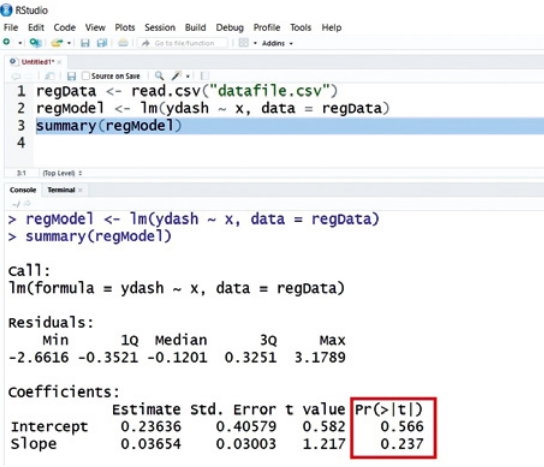
Figure 8. R output for “ proximity to the line of equality ”